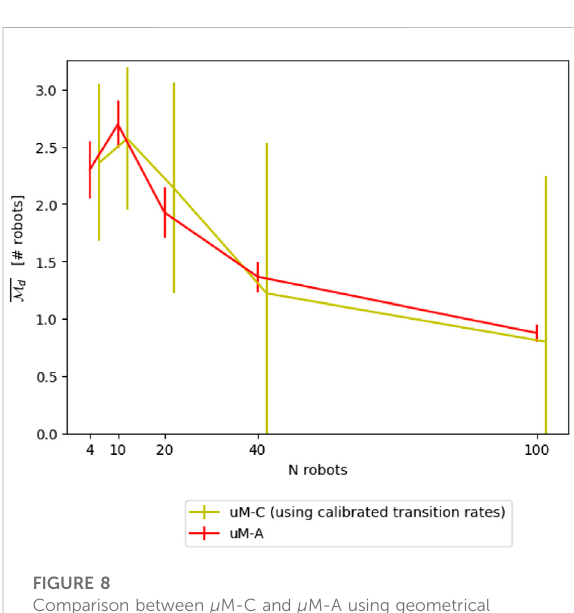
FIGURE 8 Comparison between μ M-C and μ M-A using geometrical reasoning and transition probabilities obtained through system identi fi